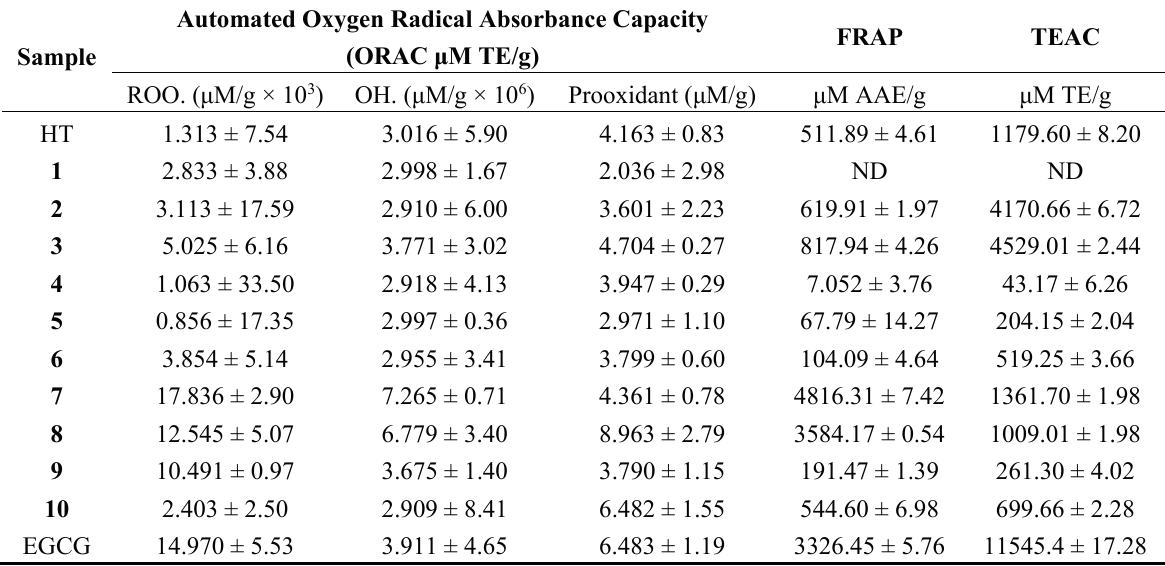
Table 2. Total antioxidant capacity of H. teretifolium